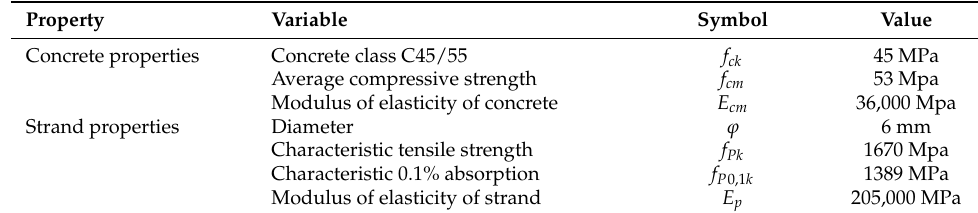
Table 2. Material